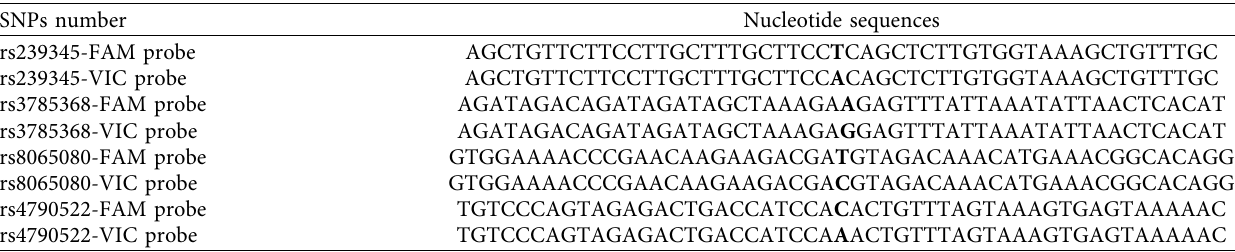
Table 1: The probe sequences from 5 ′ -3 ′ for the genotyped SNPs.